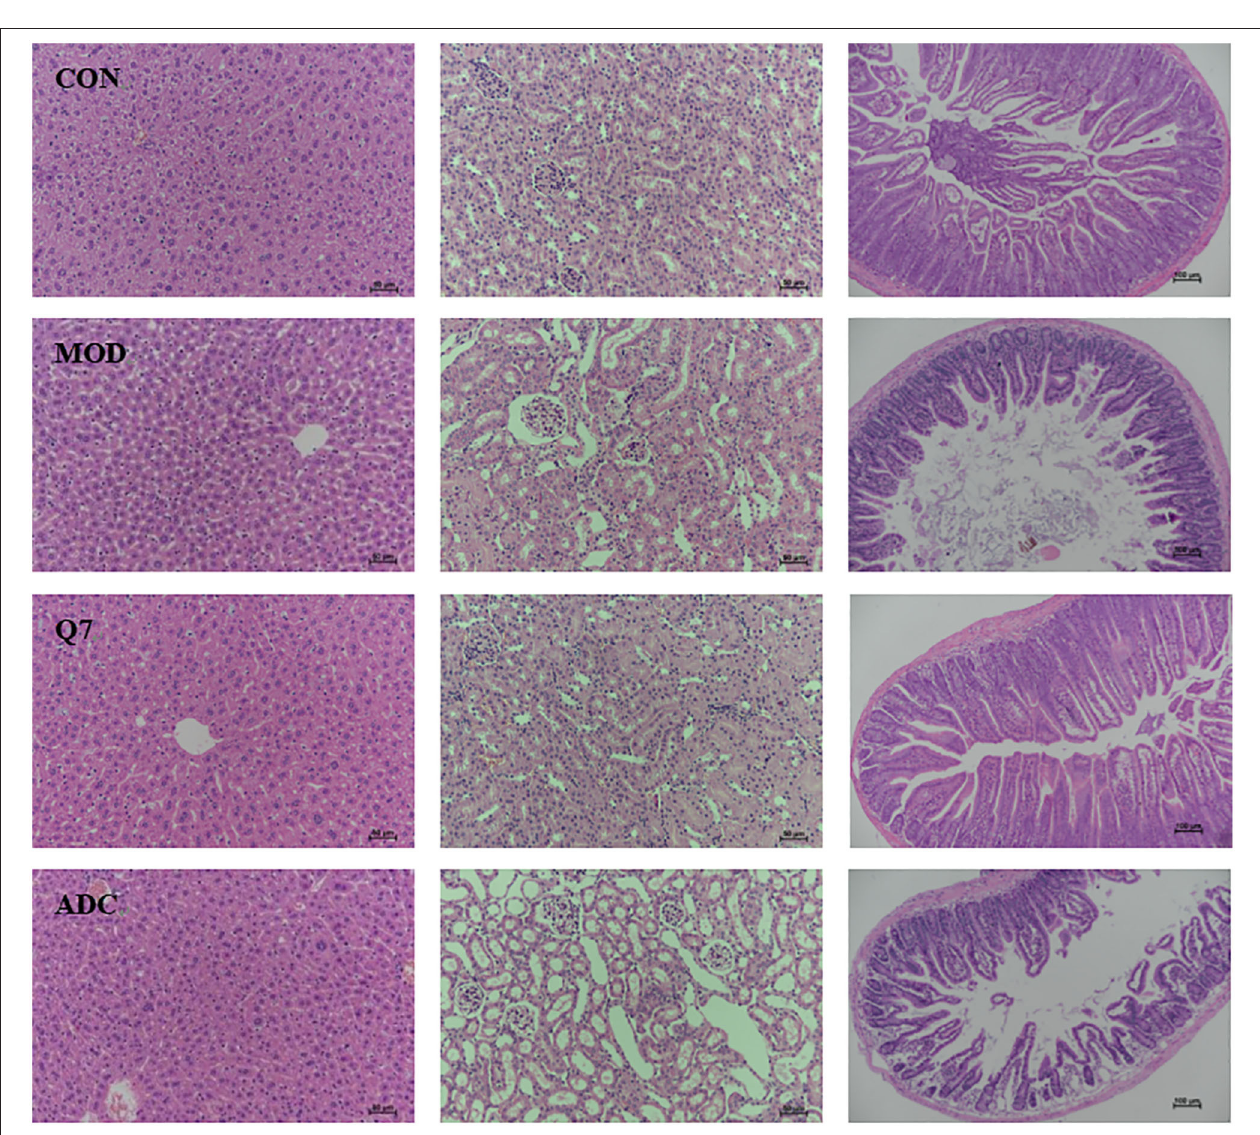
FIGURE 3 | Histopathological analyses of H&E stained liver, kidney sections ( × 200 magnification), and intense sections ( × 100 magnification) from mice.